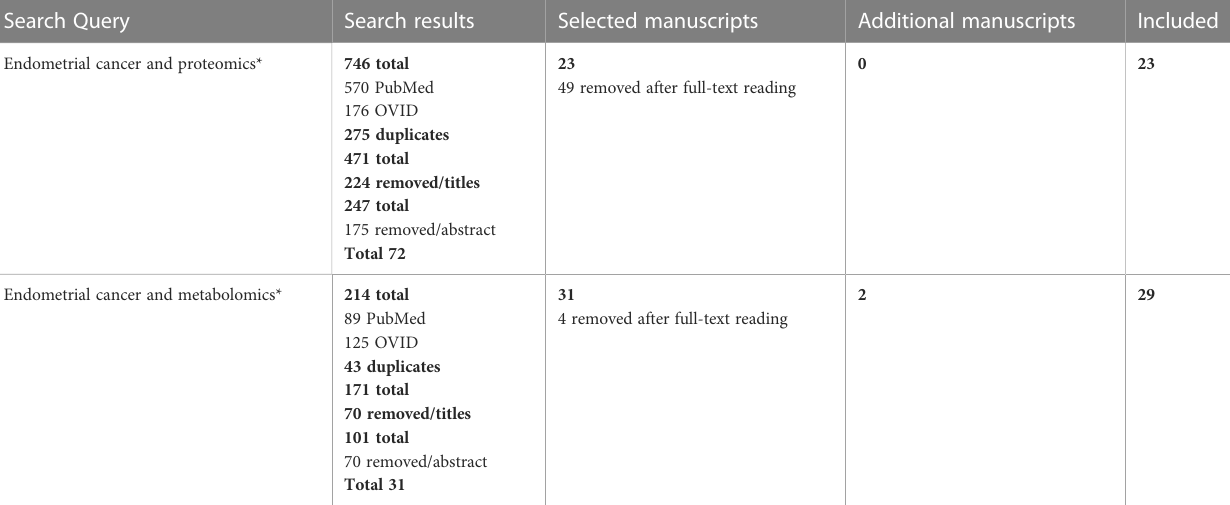
TABLE 2 Search strategy for identi fi cation of manuscripts in Pubmed and OVID Embase.